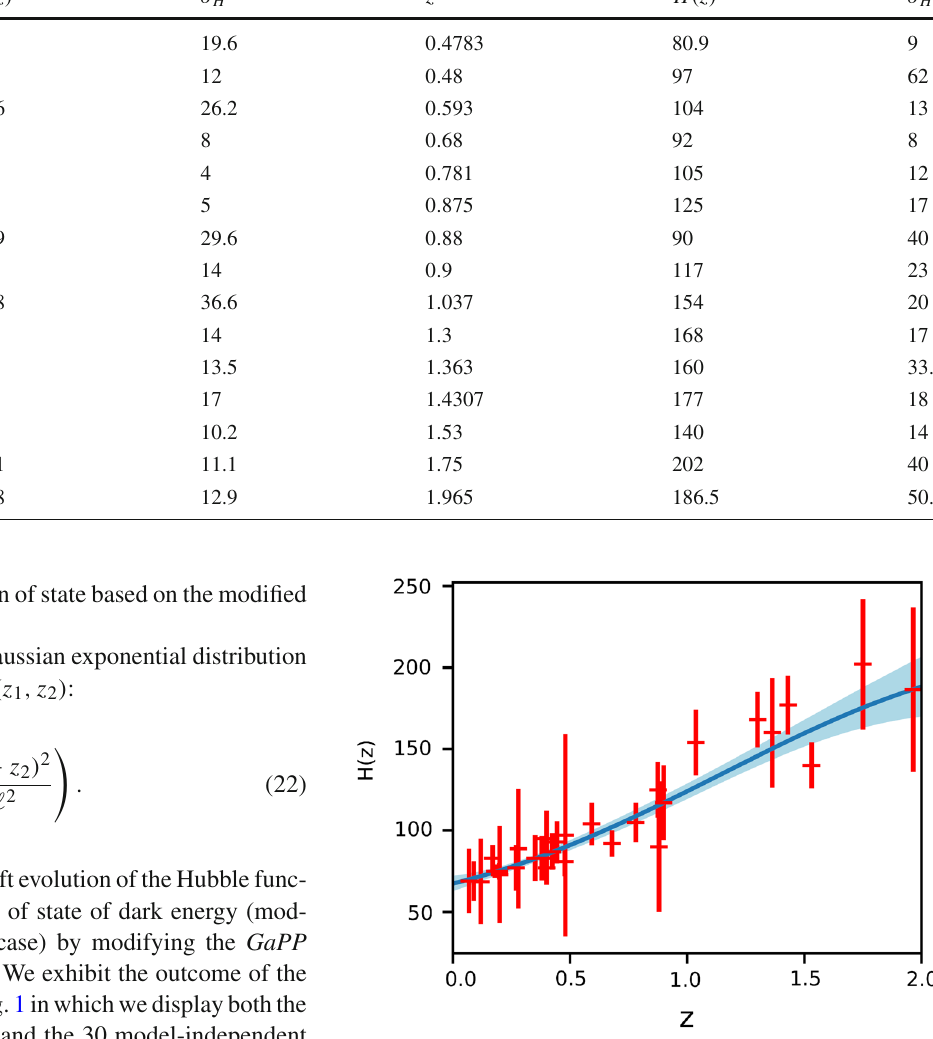
Fig. 1 The figure displays the reconstructed curve for H = H ( z ) using Gaussian process techniques assuming an exponential covariance function and the 30 model-independent measurements of H ( z ) with the corresponding error bars. The blue surface represents the 1 σ confidence region of the